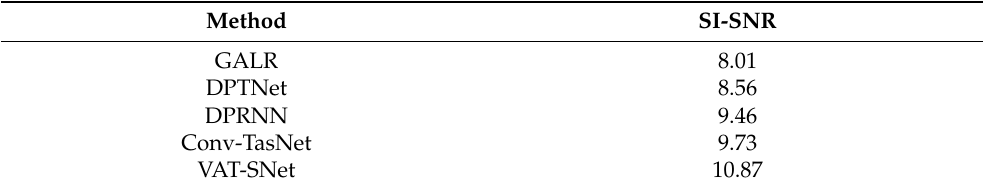
Table 3. Comparison of time-domain